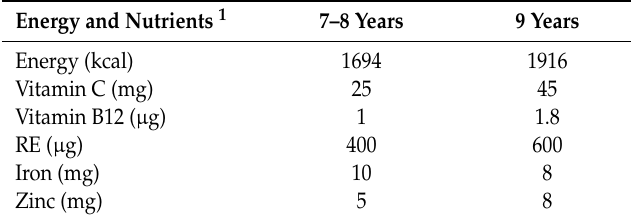
Table 1. Recommended dietary allowances of energy, vitamin, and trace elements for school-aged children.